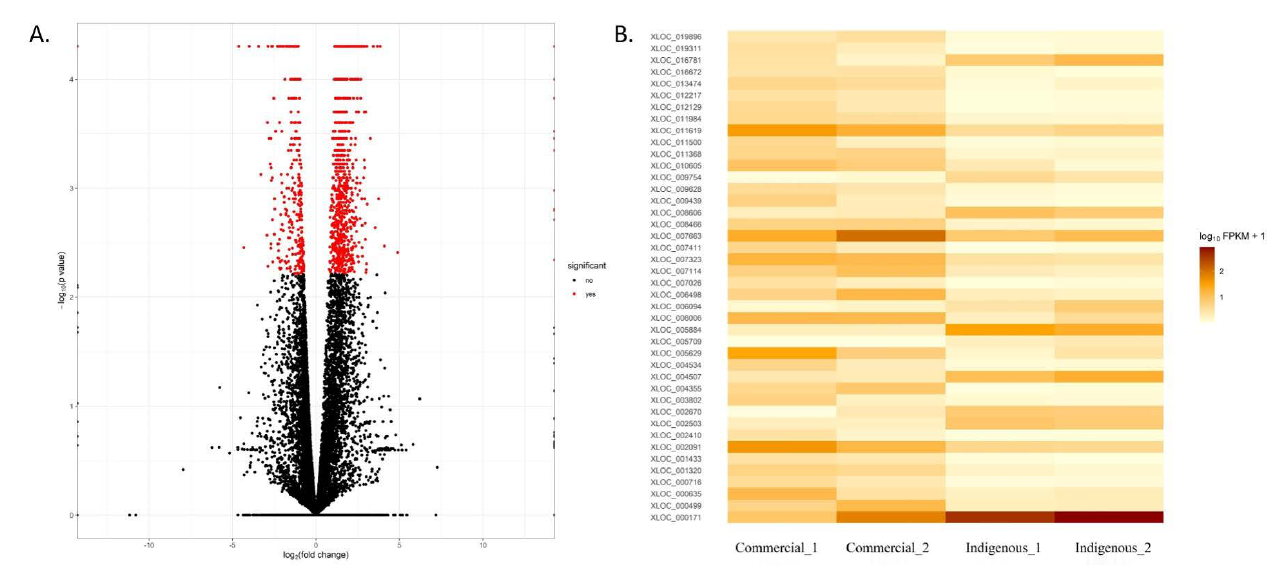
Figure 2. Analysis of differentially expressed genes (DEGs) between commercial and indigenous birds. ( A ) Log2-fold change between the commercial versus indigenous (native) breed. Light blue dots represent significant DEGs between breeds ( p -values < 0.05). ( B ) Heat map of differentially expressed genes between the commercial versus indigenous breed. Lighter color represents lower expression.